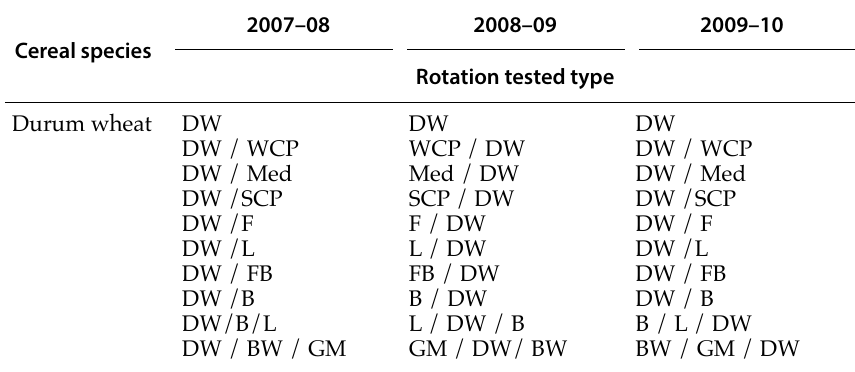
Table 1. Crop rotation applied to durum wheat at the experimental station of INRAT at Kef. Cereal